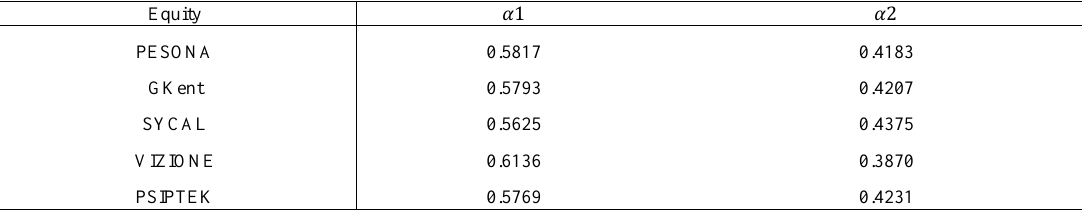
Table 5. Limiting distribution at for respective stocks for two-state